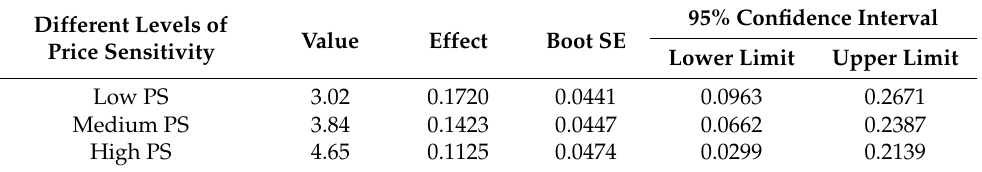
Table 9. The mediating role of EA in the relationship between OEPS and users’ GCB under different levels of PS. Different Levels of Price